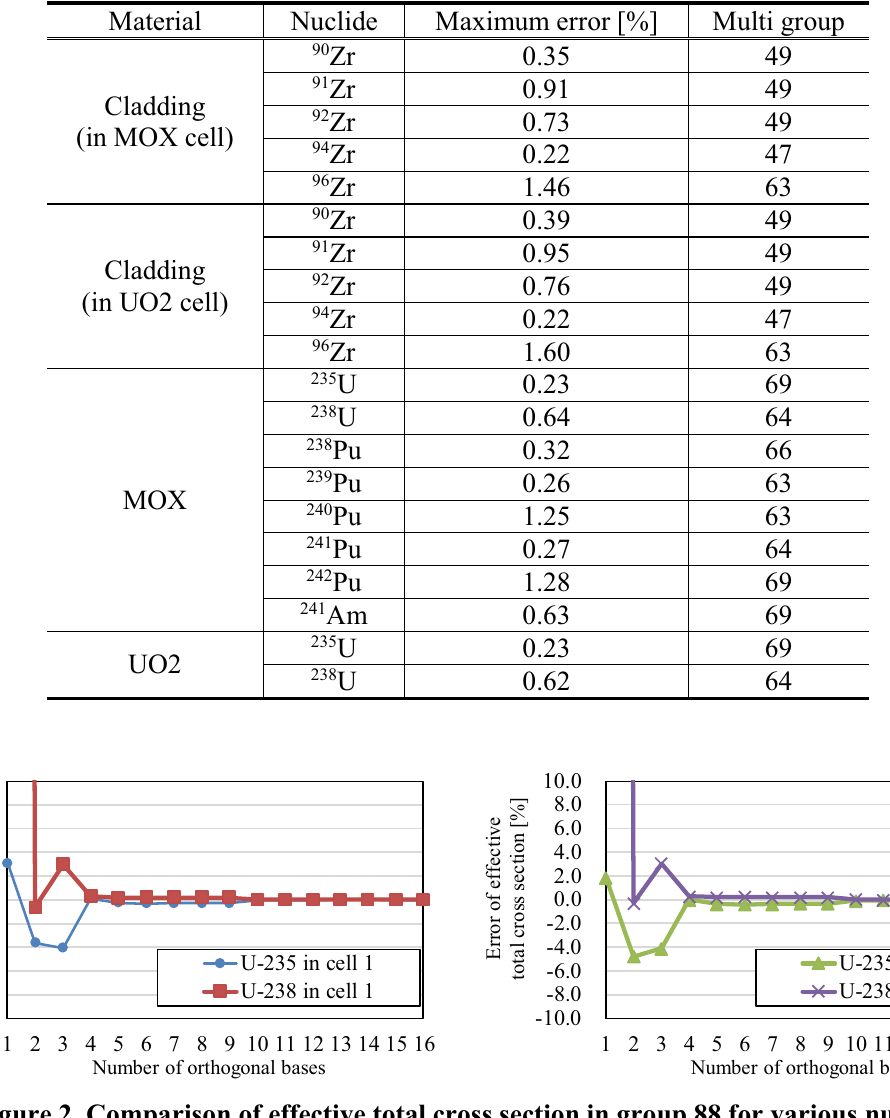
Table V. The maximum relative errors of effective total cross sections calculated by the RSE